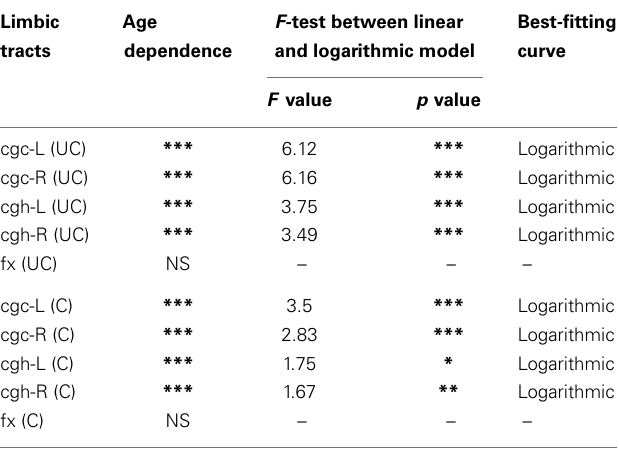
Table 4 | Relationship between radial diffusivity (RD) of limbic tracts and age